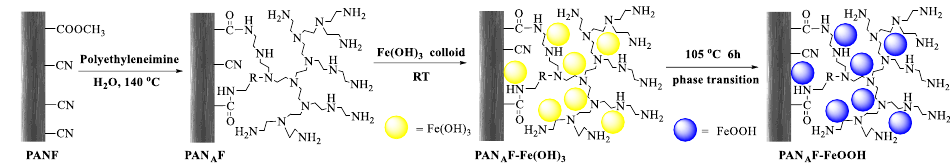
Figure 1. The preparation of FeOOH-loaded polyacrylonitrile fiber.